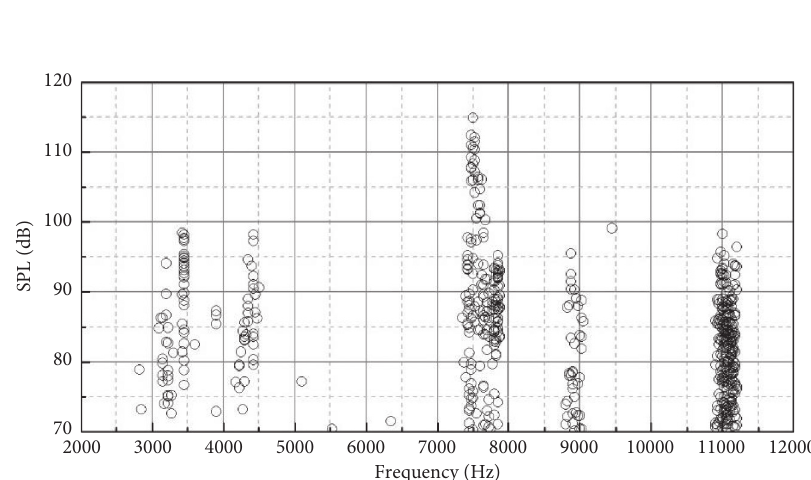
Figure 2: Noise distribution in the dynamometer